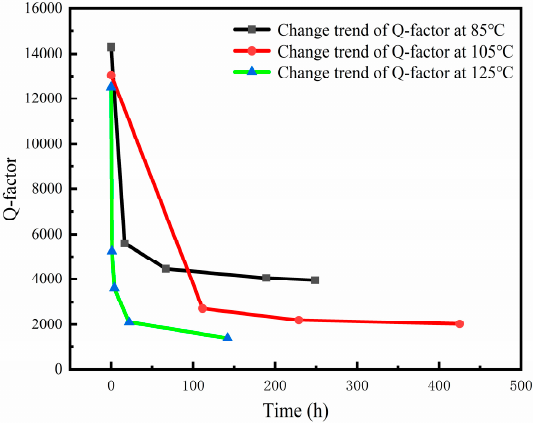
Figure 2. Q-factor test frequency response diagram and test system.